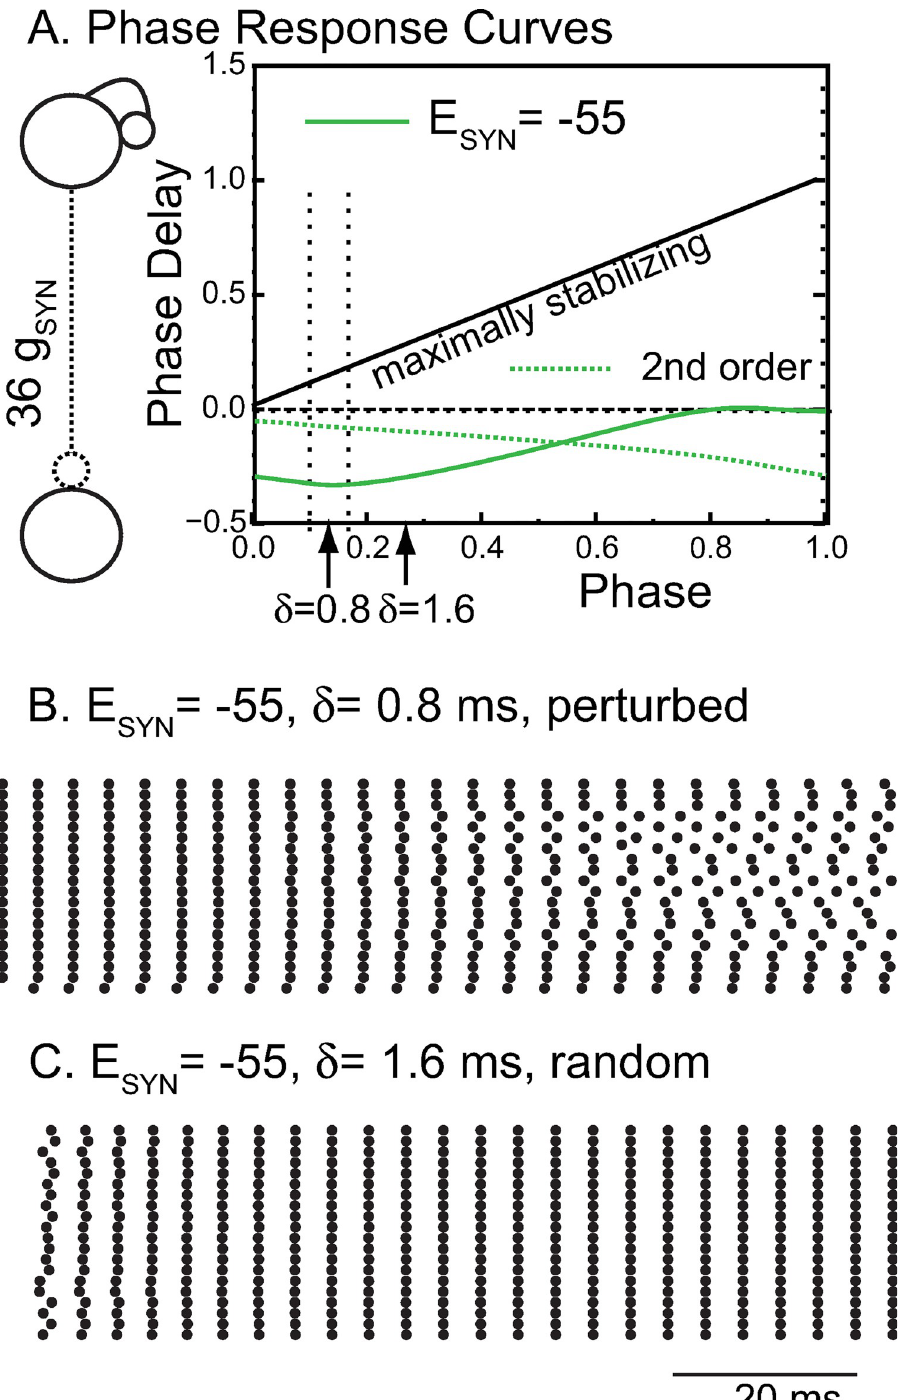
Fig 5. Phase Response Curve Explain Synchronizing Tendencies for Shunting Inhibition. A. A biexponential inhibitory postsynaptic conductance as the perturbation to a single neuron from Fig 3B1 to generate the PRC for shunting inhibition (green). The dashed green curve shows the normalized change in the cycle after the cycle that contains the perturbation (second order). The strength of an individual conductance was multiplied by 36 to reflect the 36 simultaneous inputs received by a single neuron (left inset) during perfectly synchronous oscillations. The leftmost arrows indicate the phase at which an input delayed by 0.8 ms is received in the network. The dashed lines refer to the range of synaptic delays shown in Fig 3A3 and 3B3. The free running period of this neuron is 5.97 ms at a